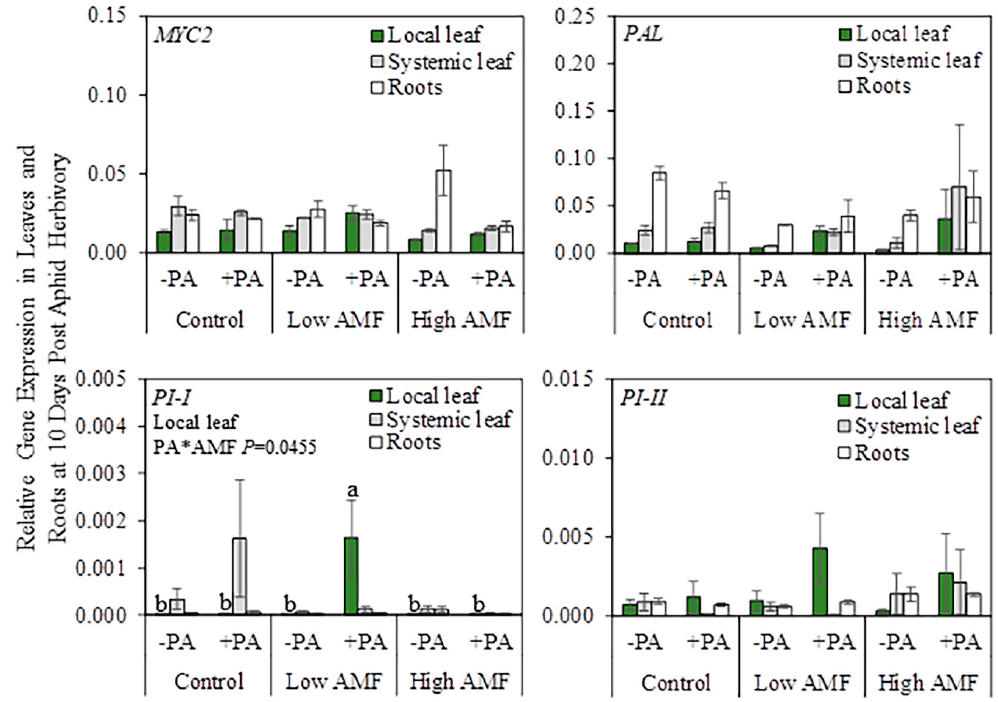
Figure 5. Relative gene expression in local leaf, systemic leaf, and roots after 10 days of herbivory by potato aphids ( Macrosiphum euphorbiae ) on potato plants ( Solanum tuberosum ). Non-infested non- mycorrhizal plants ( − PA Control); potato-aphid-infested non-mycorrhizal plants (+PA Control); non- infested plants with a low level of AM fungal root colonization ( − PA Low AMF); potato-aphid- infested plants with a low level of AM fungal root colonization (+PA Low AMF); non-infested plants